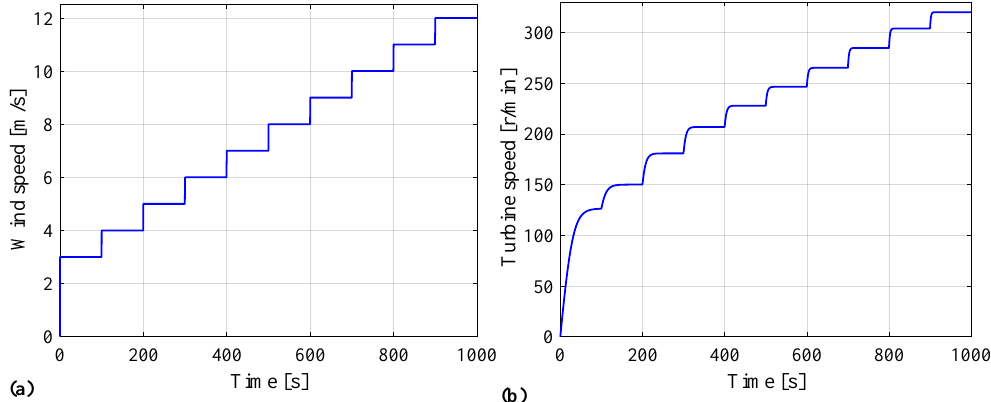
Figure 11. ( a ) Wind speed variation and ( b ) generator speed response versus time.